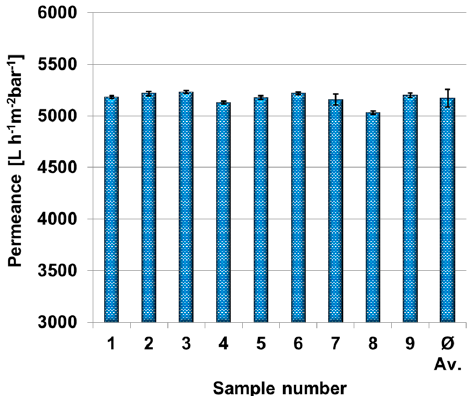
Figure 2. Permeance of nine polyethersulfone membrane samples and average value in dead-end mode. Transmembrane pressure was set to one bar. Each permeance and standard deviation were calculated out of 10 different measurement points after 10 min.